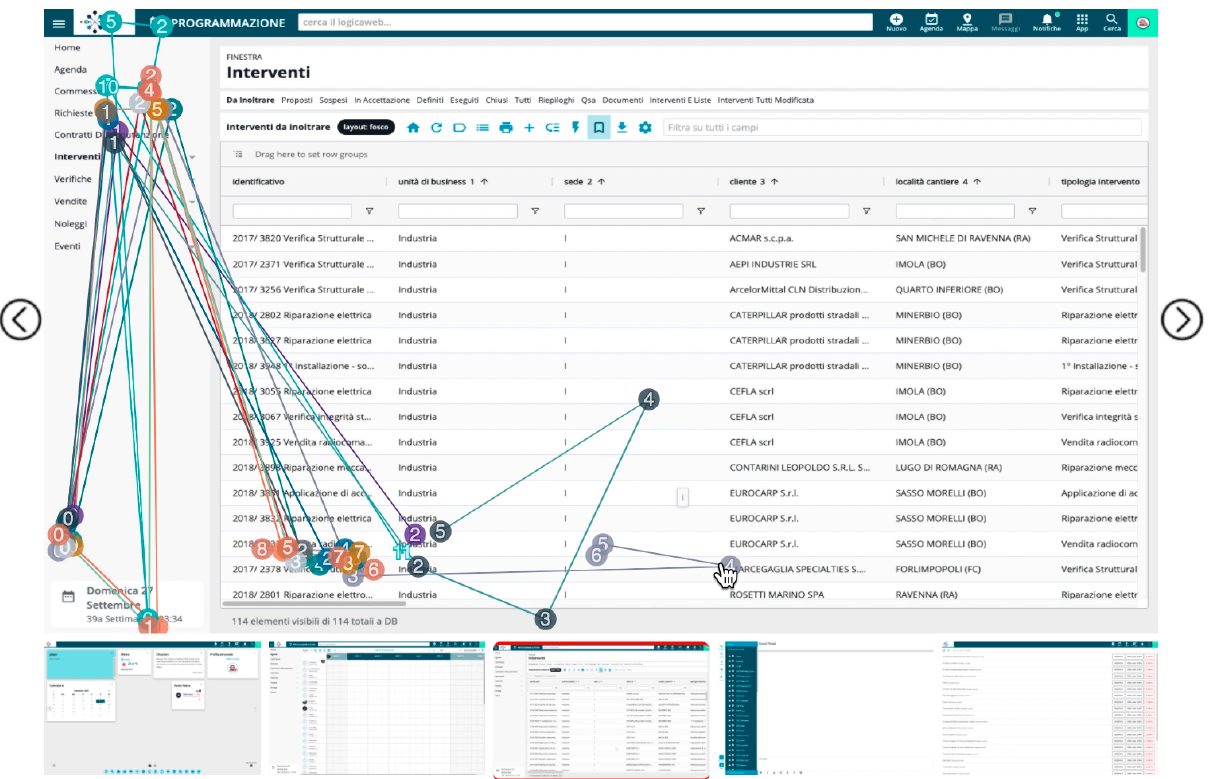
Figure 13. Collective emotions pie chart of users while performing task 2.